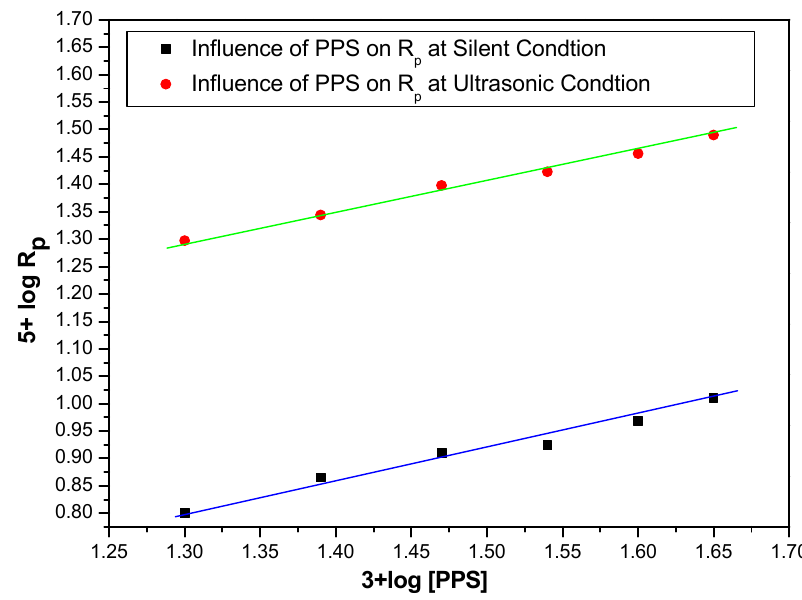
Figure 4. Bi-logarithmic plot illustrating influence of PPS concentration on the R polymerization of MABEunder US-MPTC and Silent-MPTC conditions: 1.2 × 10 − 2 mol·dm − 3 of BPMACB, 3.0 mol·dm − 3 of MABE, 0.3 mol·dm − 3 of [H + ], 0.1 mol·dm − 3 of [µ], 60 °C of temperature (50 kHz, 300 W for ultrasonic assisted reaction).